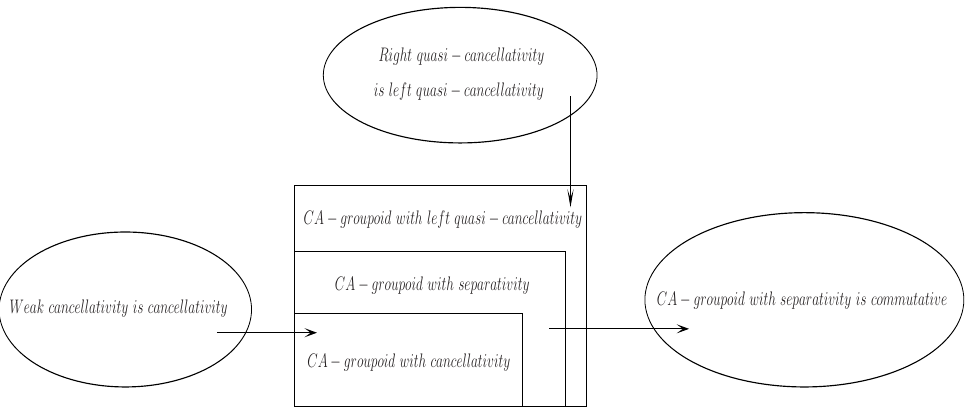
Figure 6. The main results obtained for the CA-groupoid in this